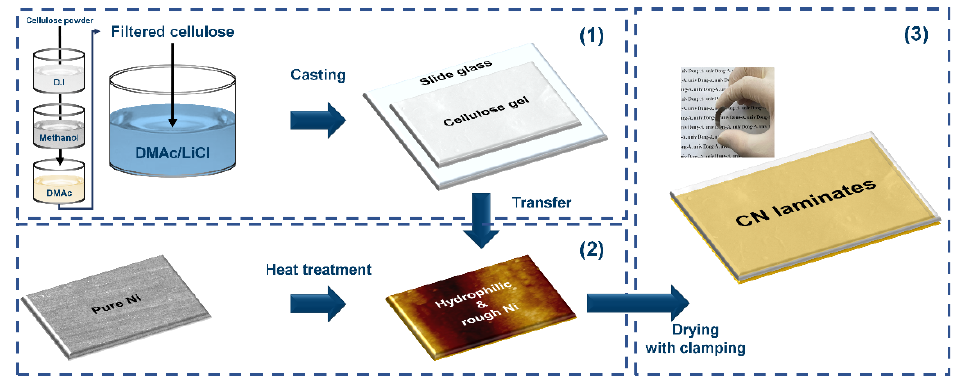
Figure 1. Schematics of the overall fabrication process of the CN laminates.